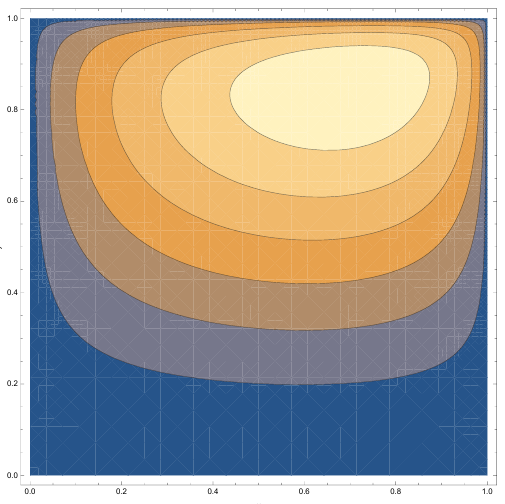
Figure A11. The bivariate Kumaraswamy density (Equation (1)) plot, where α = 1.5, β = 2.5, θ = 0.5 and δ = 0.9.